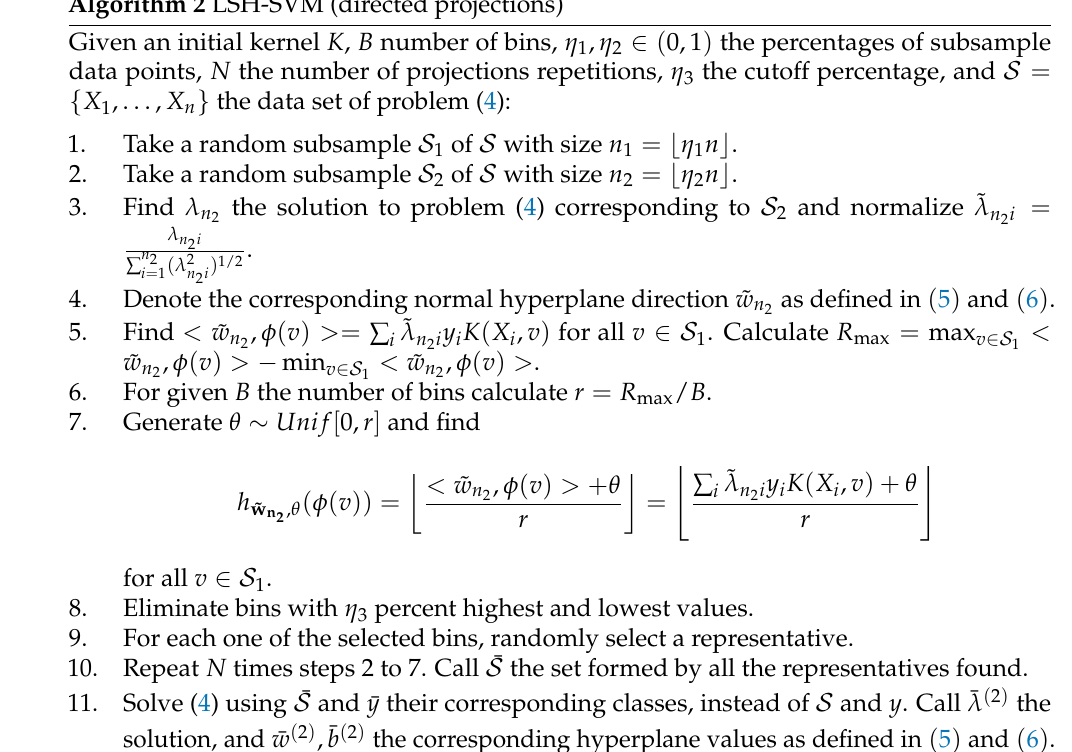
Algorithm 2 LSH-SVM (directed